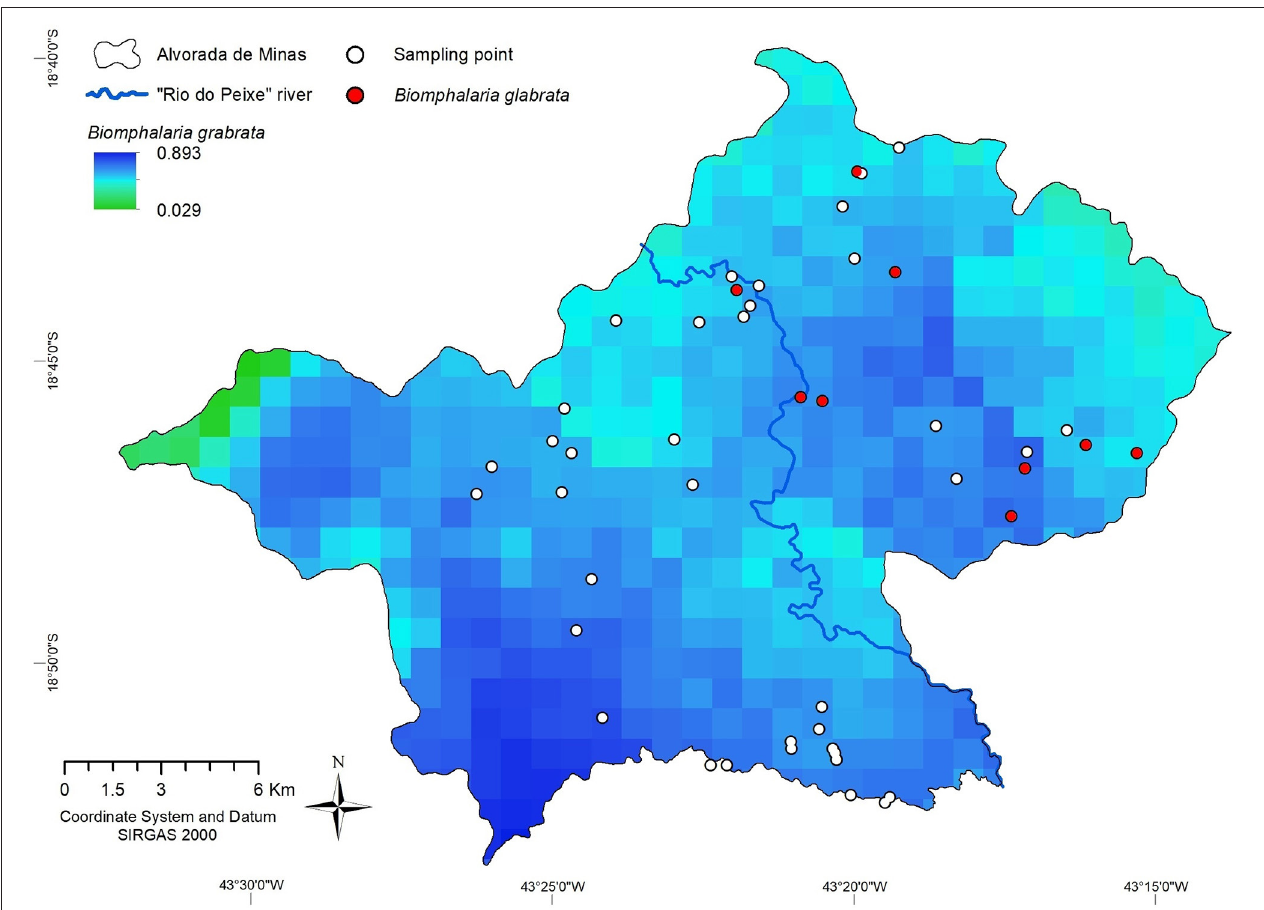
FIGURE 4 | Spatial distribution of Biomphalaria glabrata in the municipality of Alvorada de Minas, Minas Gerais, Brazil, obtained by